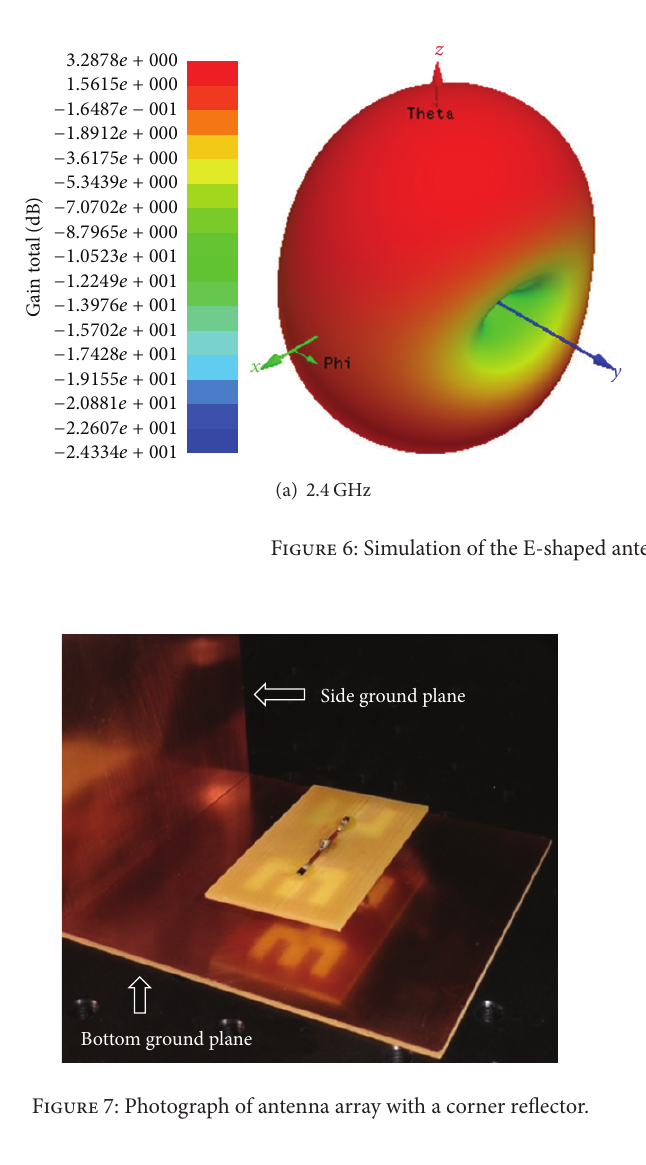
based on two arms that are as long as its guided